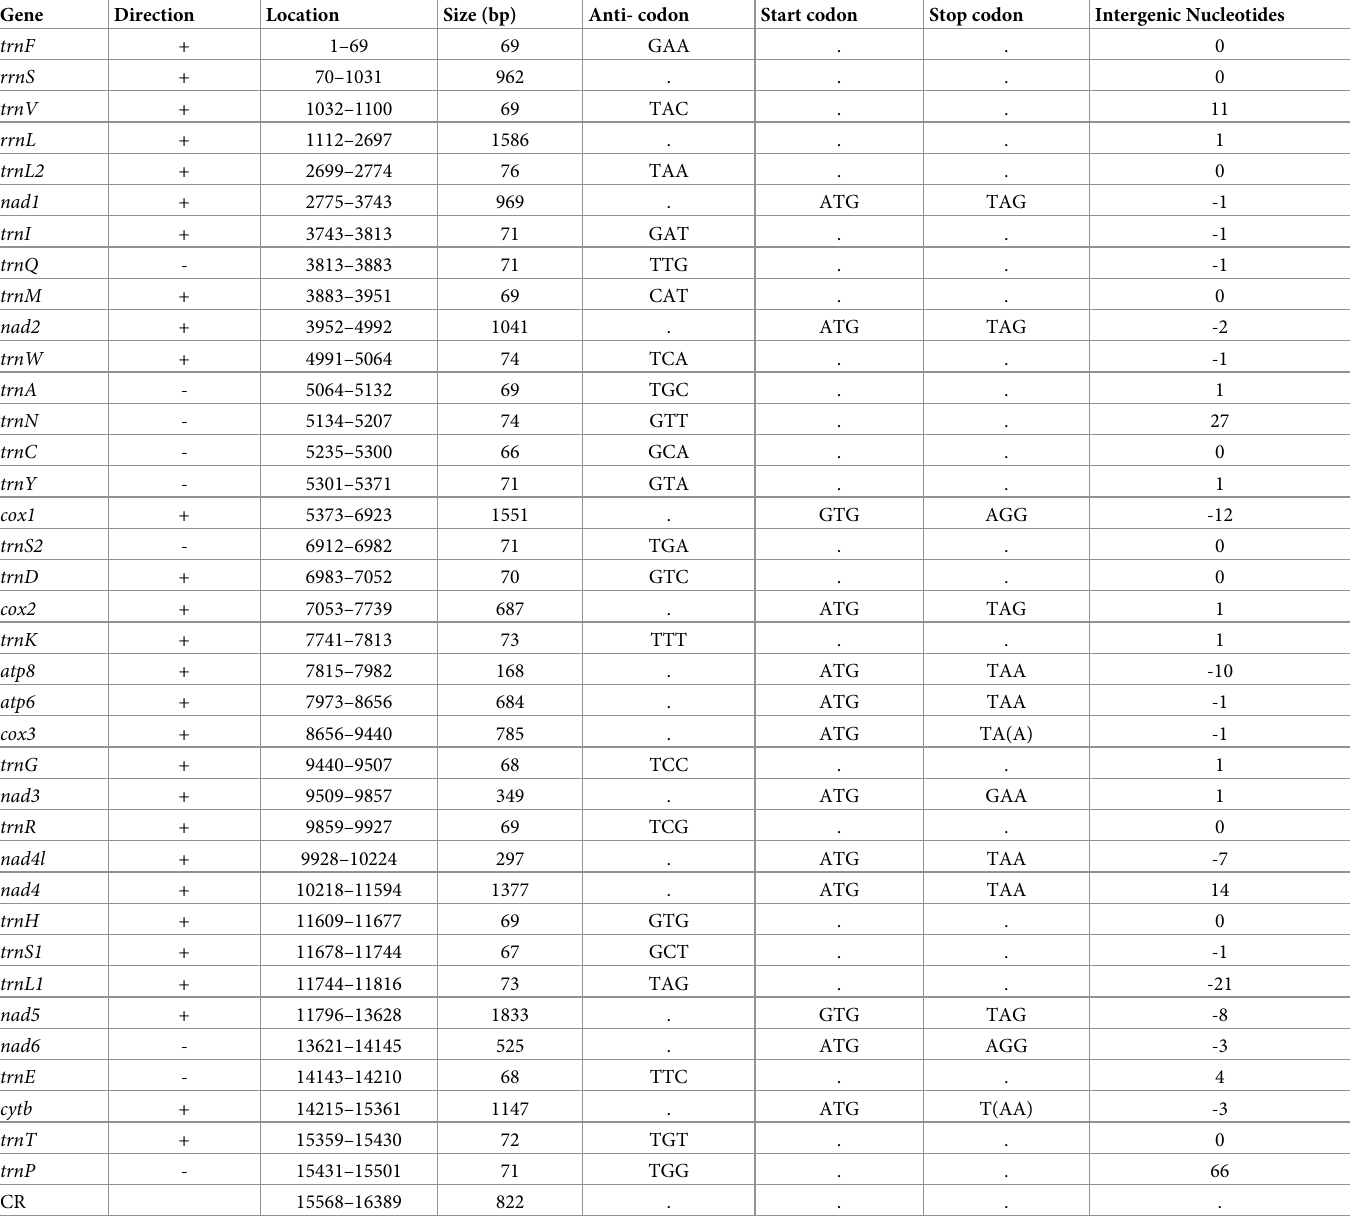
Table 1. List of annotated mitochondrial genes of Pangshura sylhetensis